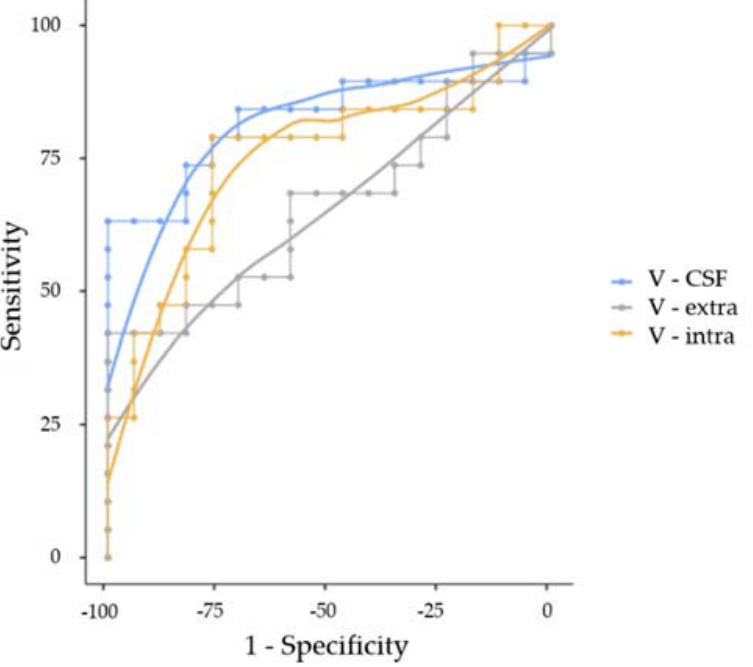
Figure 5. ROC curves of 19 patients with GBM and 17 with cerebral metastases showing a high predictive value of both perilesional T2 V-CSF (AUC 0.824) and V-intra (AUC 0.752) regarding the presence of a GBM.